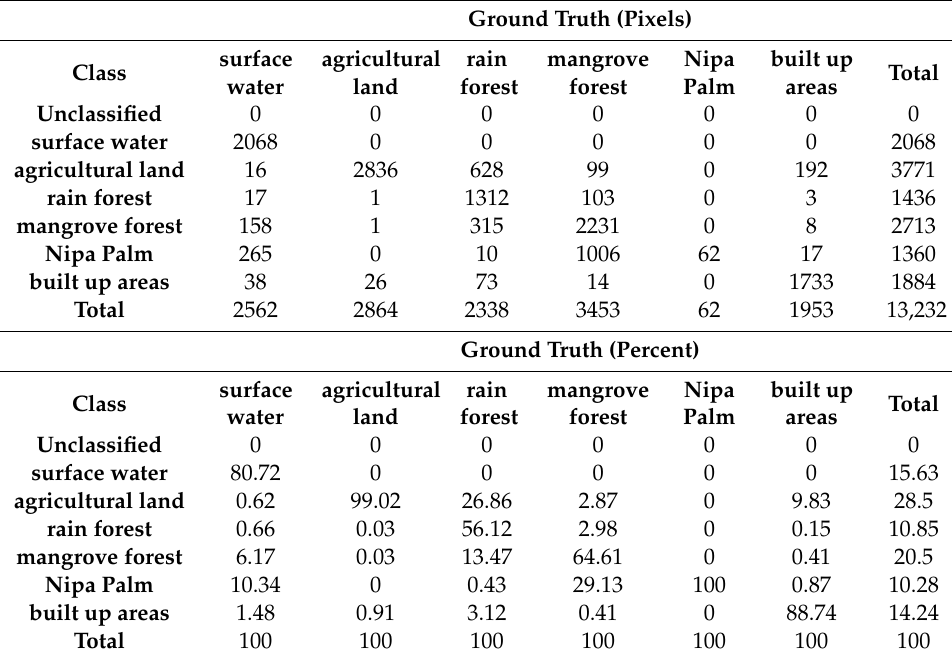
Table A2. Confusion Matrix of the 2017 ML Land Cover Classification of the Niger